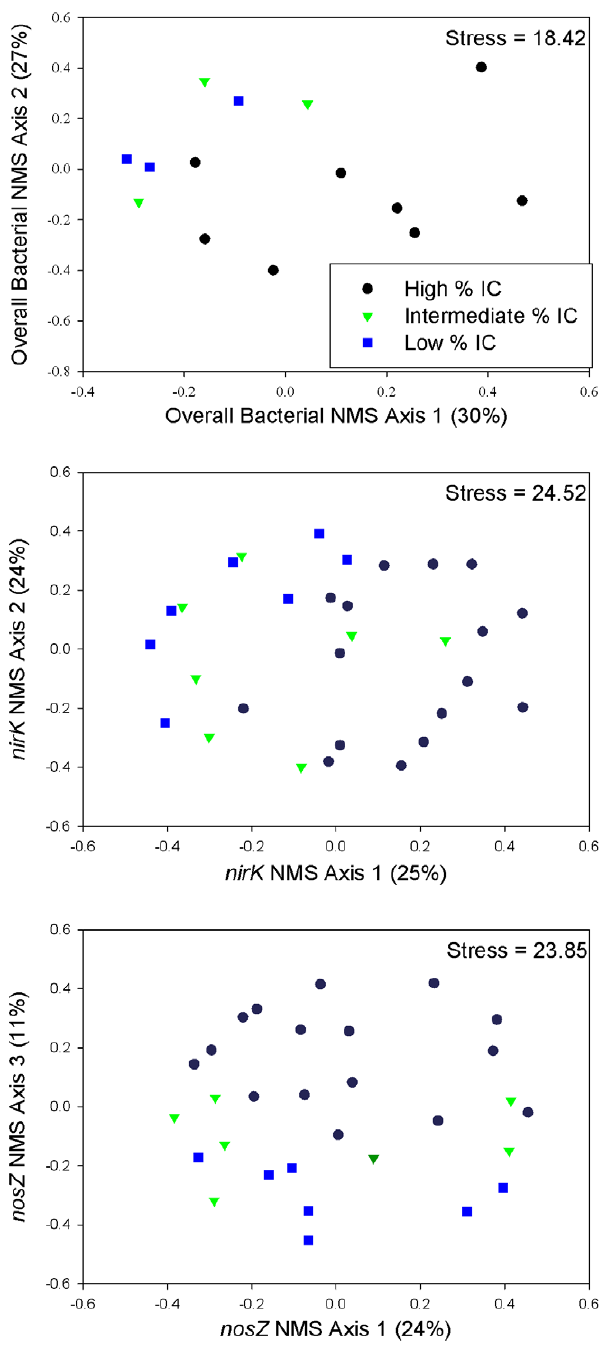
Figure 2. Non-metric multidimensional scaling (NMS) ordina- tion of overall bacterial and nirK and nosZ denitrifier commu- nities based on presence-absence TRFLP (terminal restriction fragment length polymorphism) data. Each point represents the community in a study stream on a particular sampling date. Black circles are streams in watersheds with high percent impervious cover (% IC). Green triangles are streams in watersheds with intermediate % IC. Blue squares are streams in watersheds with low % IC. Values given in parentheses following axes titles are estimated R 2 values for individual axes. All three NMS ordinations had a final solution with three dimensions. Total R 2 values for overall bacterial, nirK , and nosZ ordinations were 0.70, 0.55, and 0.59, respectively.